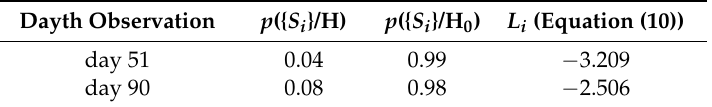
Figure 8. The SPRT index result for detecting impending bearing deterioration. Table 7. Example calculation of L i in one day observation.